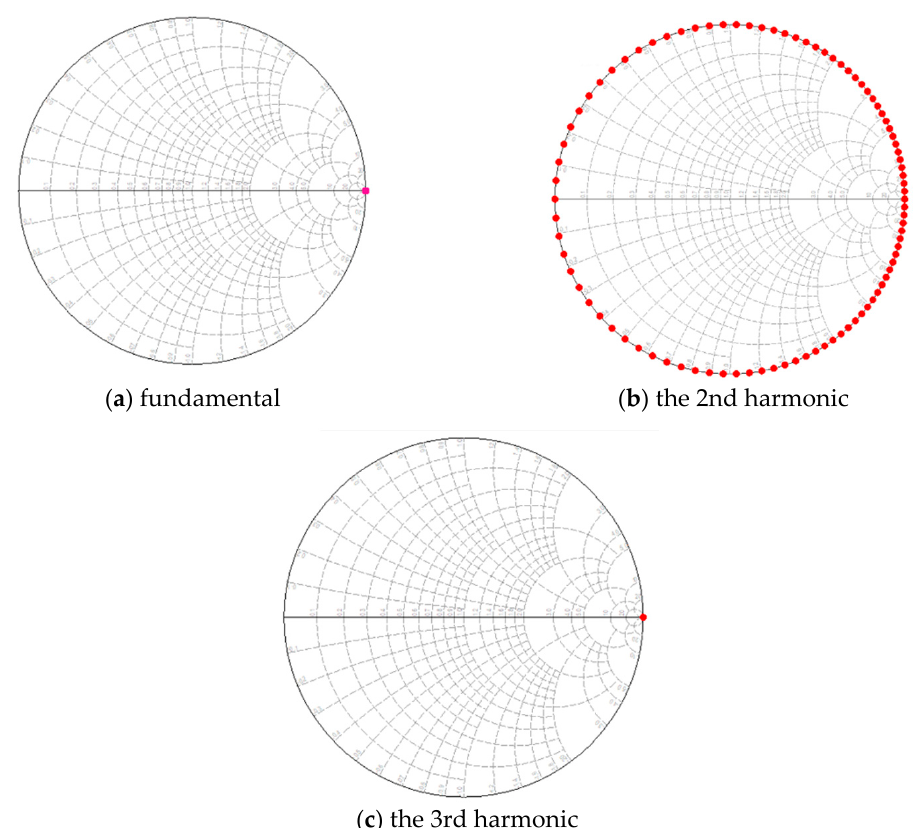
Figure 3. For different length of the stub l 10 : the position of the input impedance of the DC-pass filter in the Smith Chart.